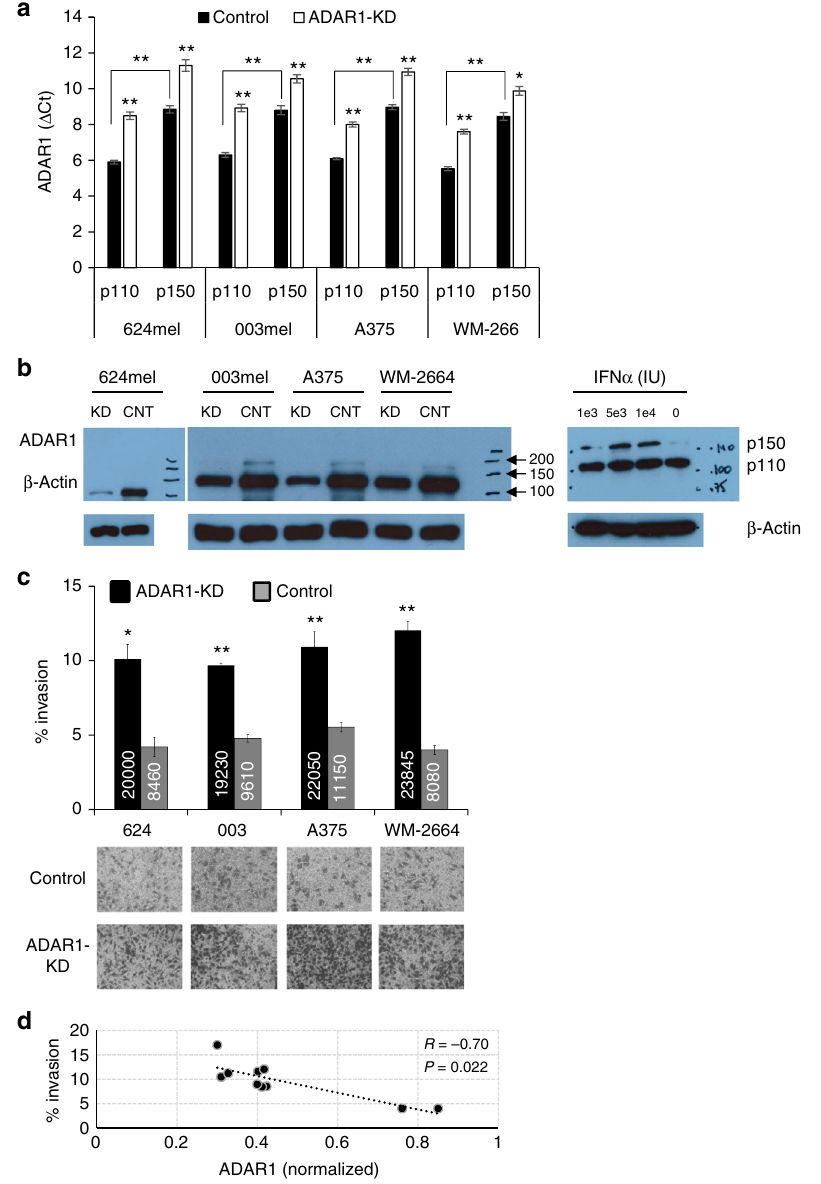
Fig. 1 Reduced ADAR1 expression leads to increased melanoma invasion. ADAR1 reduced expression in four melanoma cell lines following ADAR1 silencing (ADAR1-KD, KD) or negative control (control, CNT) as determined by a qRT-PCR selective for p110 and p150 ADAR1 variants and b left: western blot using antibodies against ADAR1 and β -actin as loading control (grouping of images from different gels). Results are representative experiment out of three biologically independent performed; right: western blot for ADAR1 of 624mel cells treated with IFN α . The exponent numbers indicate the amount of international units (IU) used; c invasive behavior of ADAR-KD vs. control cell systems (as detailed above). Invasion was performed for 24 h using Boyden chamber assay and monitored by standardized XTT assay or membrane fi xation and staining. Error bars indicate ± SEM. Numbers in the bars represent the absolute cell count of invading cells. Representative microphotographs of thincerts are shown; d correlation between % invasion and ADAR1 expression quanti fi ed by qPCR and normalized to reference melanocytes, in 10 cell lines. Correlation coef fi cient was determined with Spearman ’ s test. Asterisks represent P values: * P < 0.05; ** P < 0.01 (two-tailed t